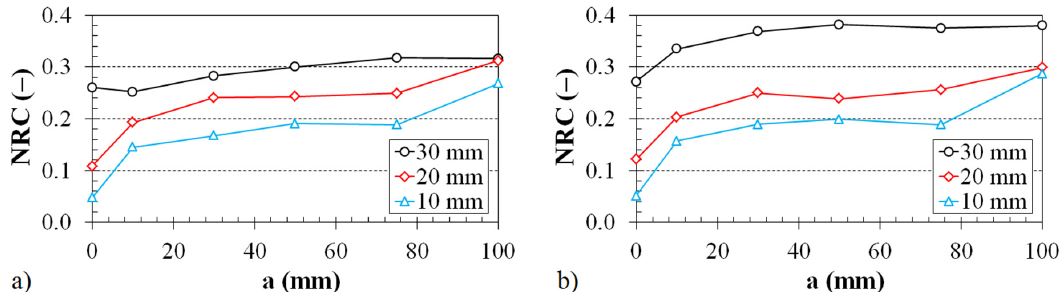
Figure 8. Noise reduction coefficient vs. air gap size dependencies for the investigated ABS samples with ( a ) Cartesian and ( b ) Octagonal structures. Inset legend: sample thickness.